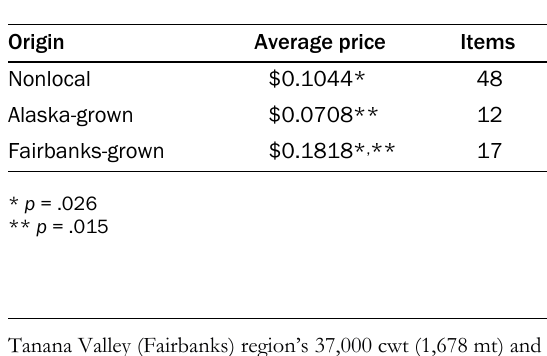
Table 5. Price Comparison by Point of